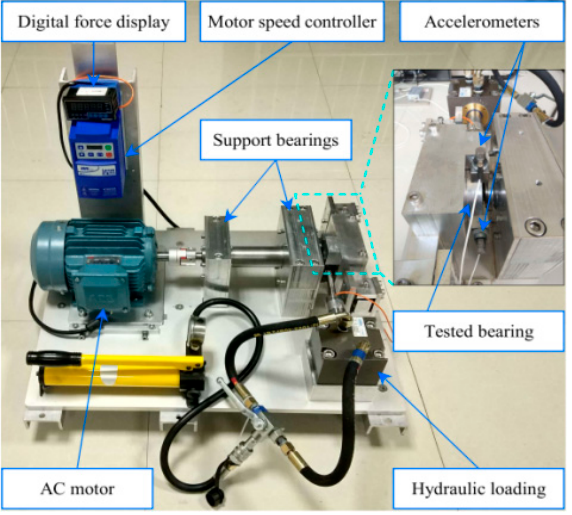
Figure 19. Bearing testbed.